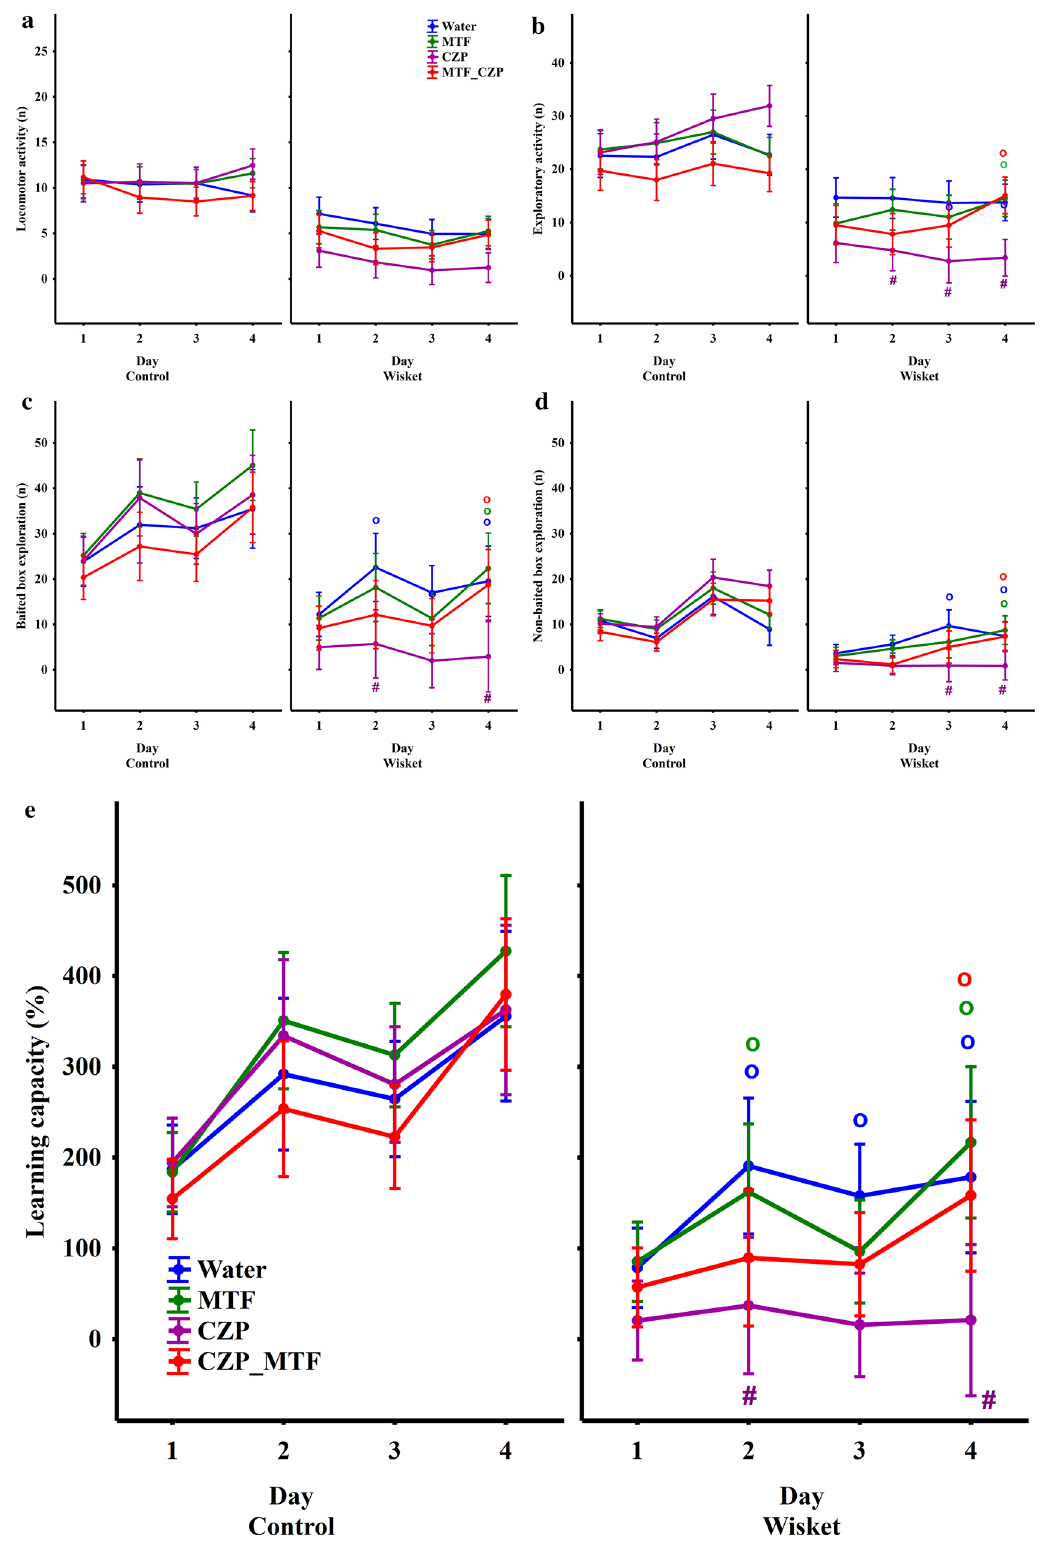
Figure 3. Time-course curves of the locomotor ( a ) and exploratory ( b – d ) activities, as well as the learning capacity ( e ), according to group. The symbols indicate significant differences between the Wistar and Wisket groups (*), compared with the water-drinking group (#), and Day 1 values